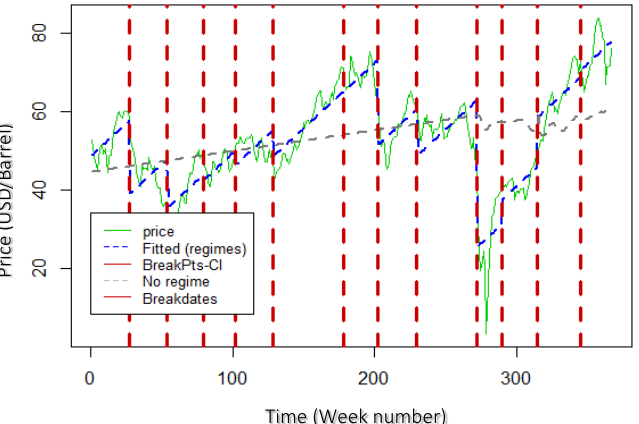
Figure 12. Worldwide Deaths caused by COVID-19 (until 31 December 2021).